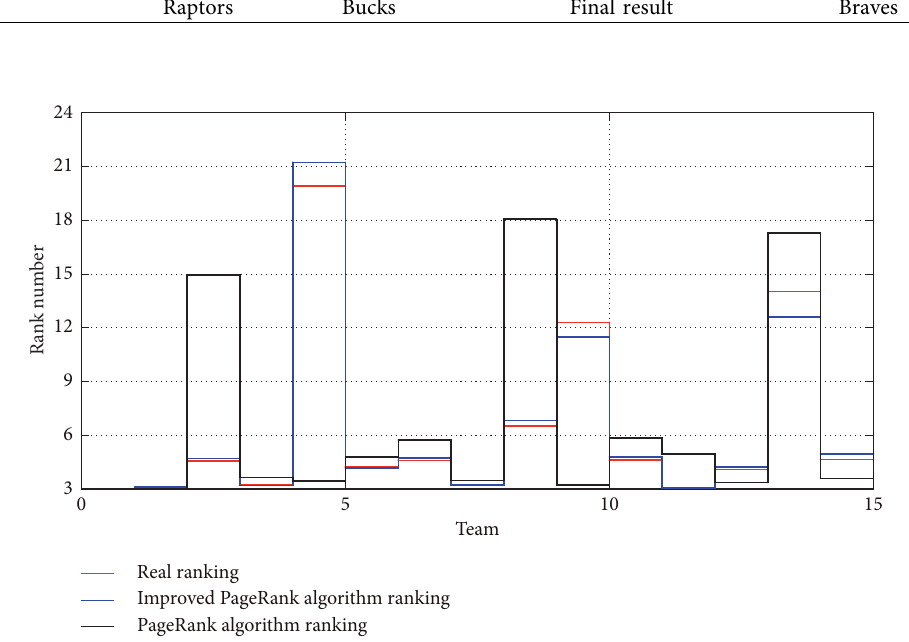
Figure 6: Qualifying predictions of eastern